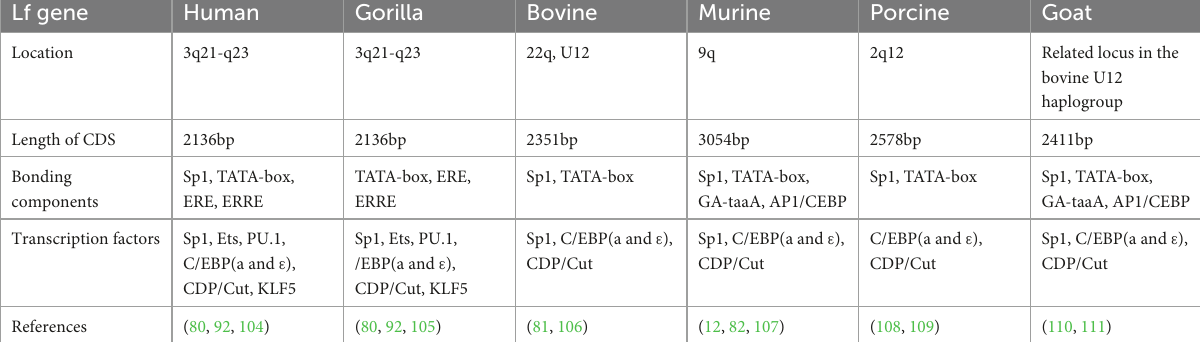
TABLE 1 Composition of lactoferrin genes in human, bovine, murine, and porcine. Lf